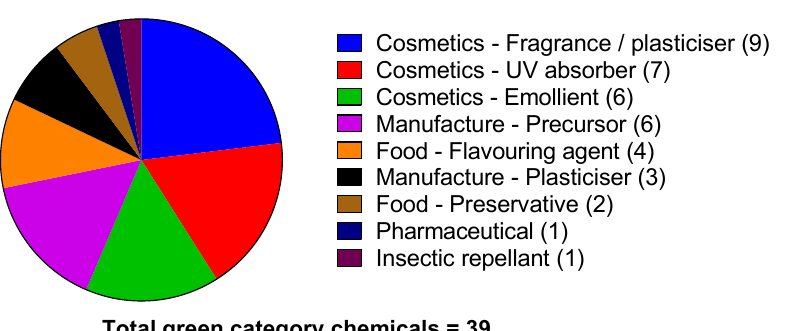
Figure 2. Exclusion characteristics of red and orange category chemicals, and the source/most- common commercial use of the green category chemicals.